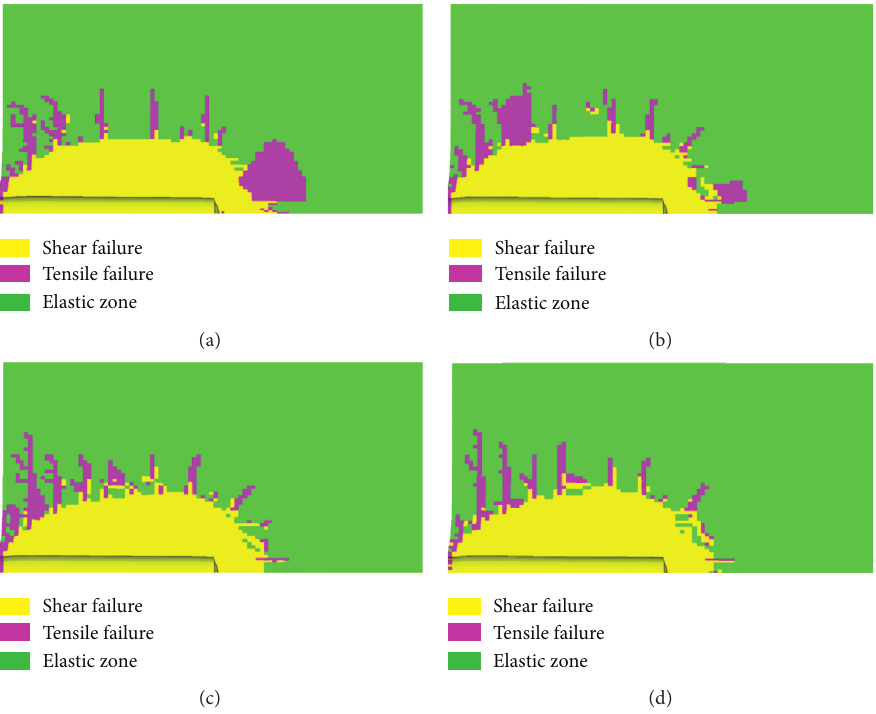
Figure 22: Blast-induced damage on the symmetrical plane under different pressure. (a) P � 10 MPa. (b) P � 20MPa. (c) P � 30MPa. (d) P � 40MPa.